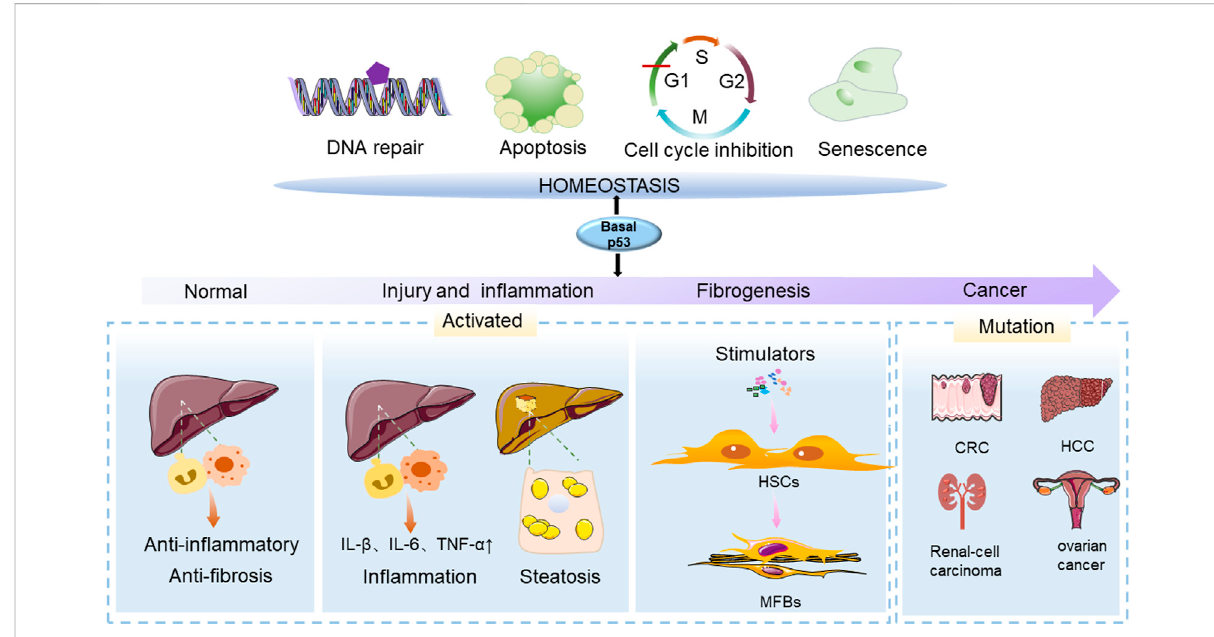
The function of p53 in physiological and pathological conditions of the liver. The p53 gene (TP53) is an important regulator in maintaining cellular homeostasis and can control cellular survival processes such as cell cycle arrest, apoptosis, senescence, DNA damage and differentiation. The effects of p53 on the liver are varied at different stages of liver injury. During the initial stage of p53 activation, it has anti-in fl ammatory and anti- fi brotic properties. In the presence of chronic liver injury, p53 activation and senescence in HSCs promote HSC accumulation, leading to the development of liver disease. Mutated p53 acquires carcinogenic properties, and contributes to the development of